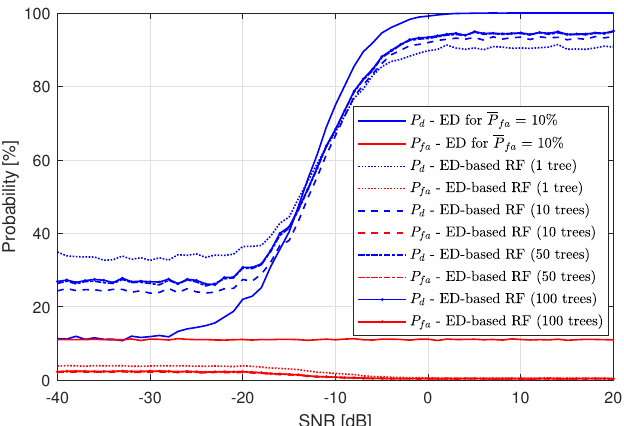
Figure 8. Resulting probability of detection P d and probability of false alarm P fa of the Energy Detection-based Random Forest method for ¯ P fa = 10%.